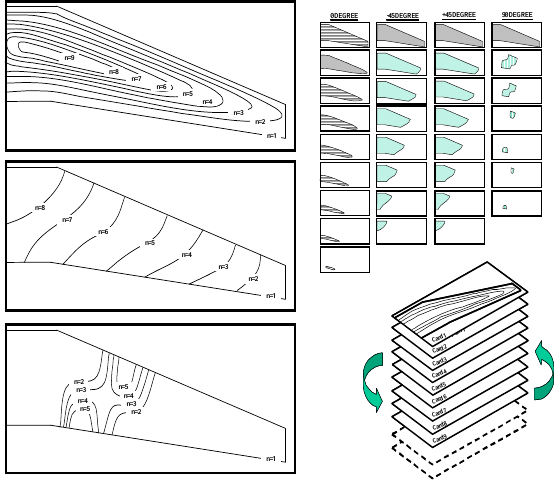
Fig. 22: Left) Thickness distributions for a 0, +/-45 and 90 degree plies with level curves showing where 1, 2, 3, 4 .. plies are required. Top right) Level curves are interpreted into global ply definitions. Bottom Right) A global stacking sequence optimization is performed shuffling global ply de- finition cards. This step is performed using a perturbation GA.